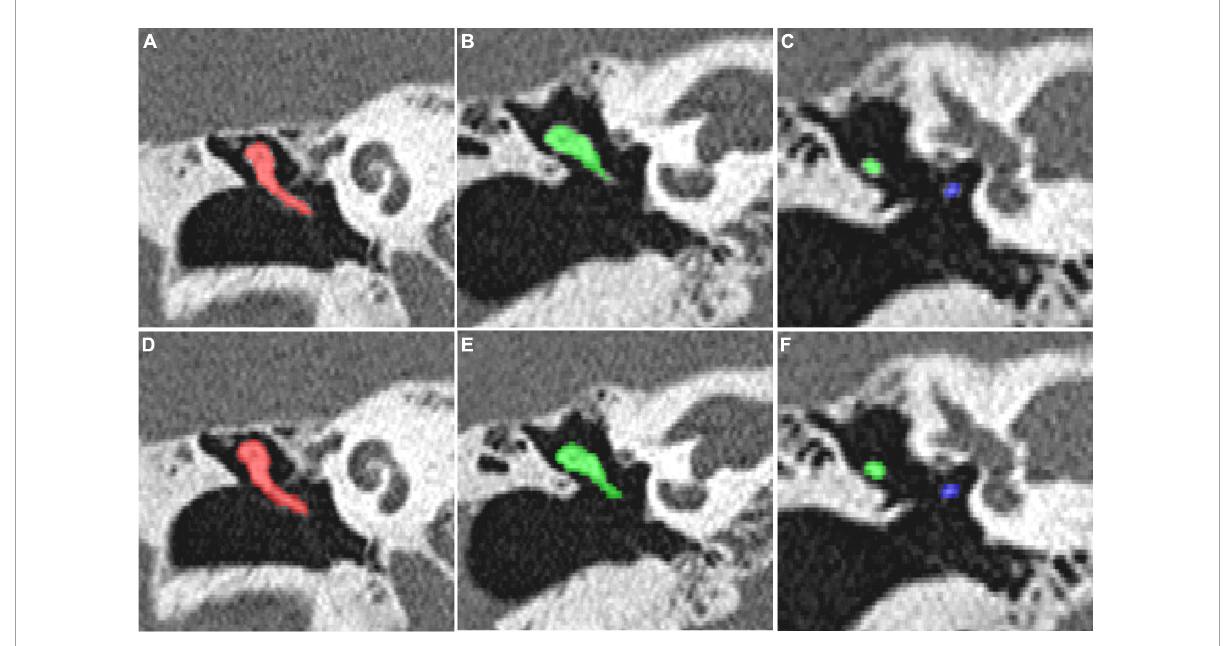
FIGURE4 (A–C) The manual segmentation of the auditory ossicles; (D–F) the automatic segmentation of the auditory ossicles using the V-Net